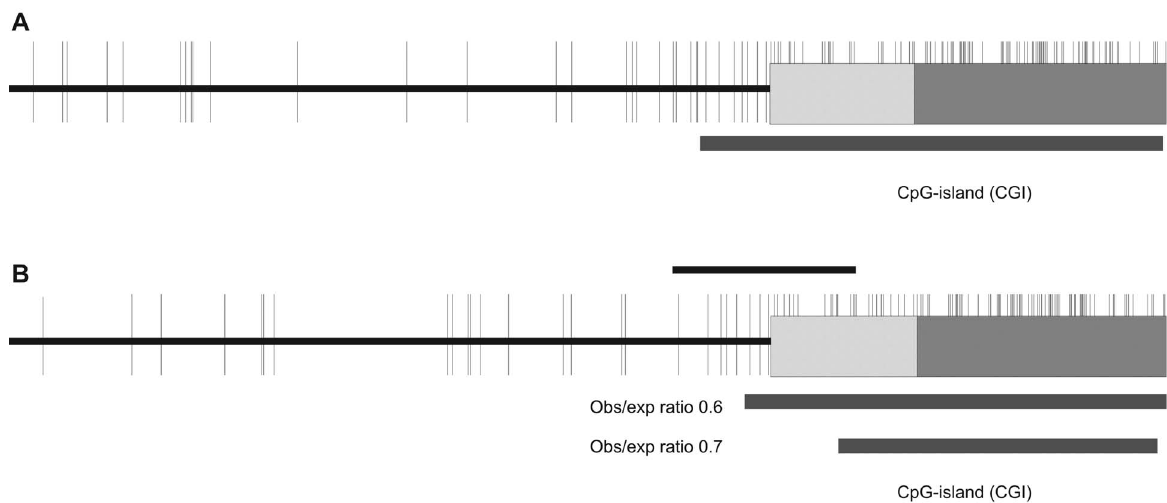
Figure 4 Schematic representation of the human LOX (A) and the mouse Lox (B) gene from -2000 to q 1000 bp estimated from the transcription start site